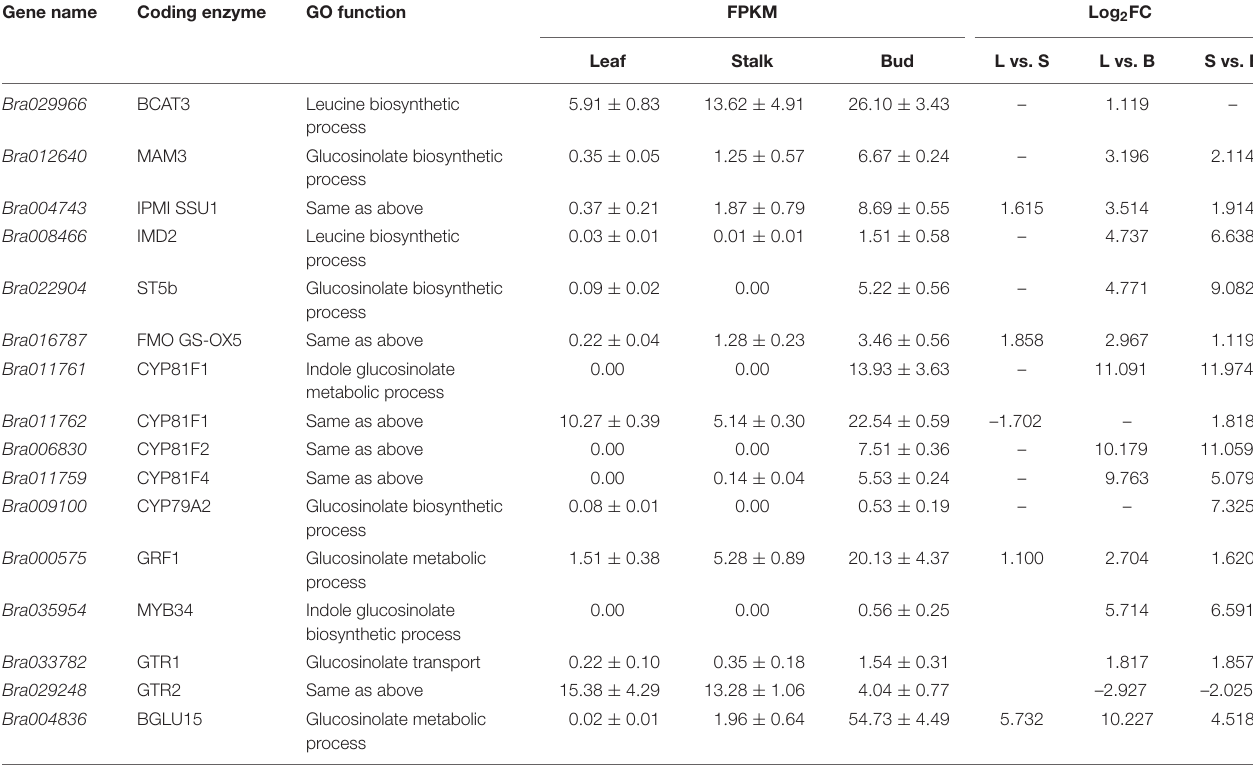
TABLE 3 | Analysis of key differentially expressed genes closely associated with glucosinolate